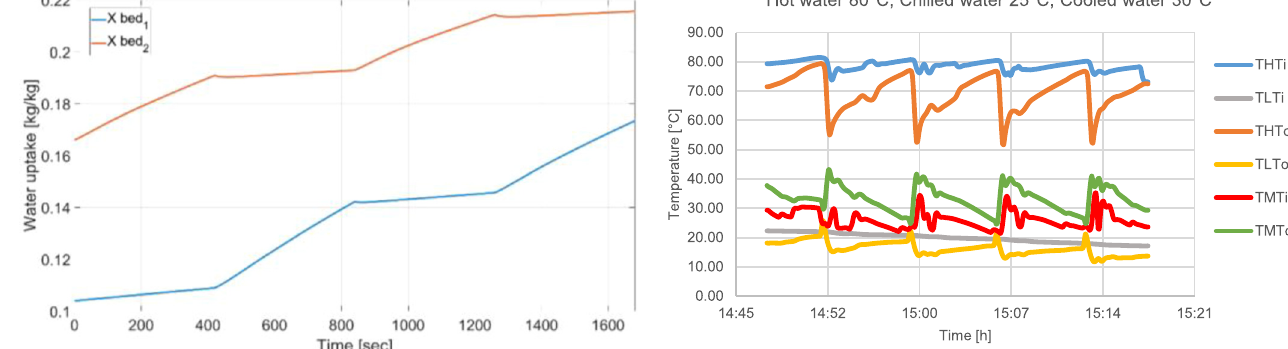
Fig. 6. Temperature variation at 80 ° C/25 ° C/30 °